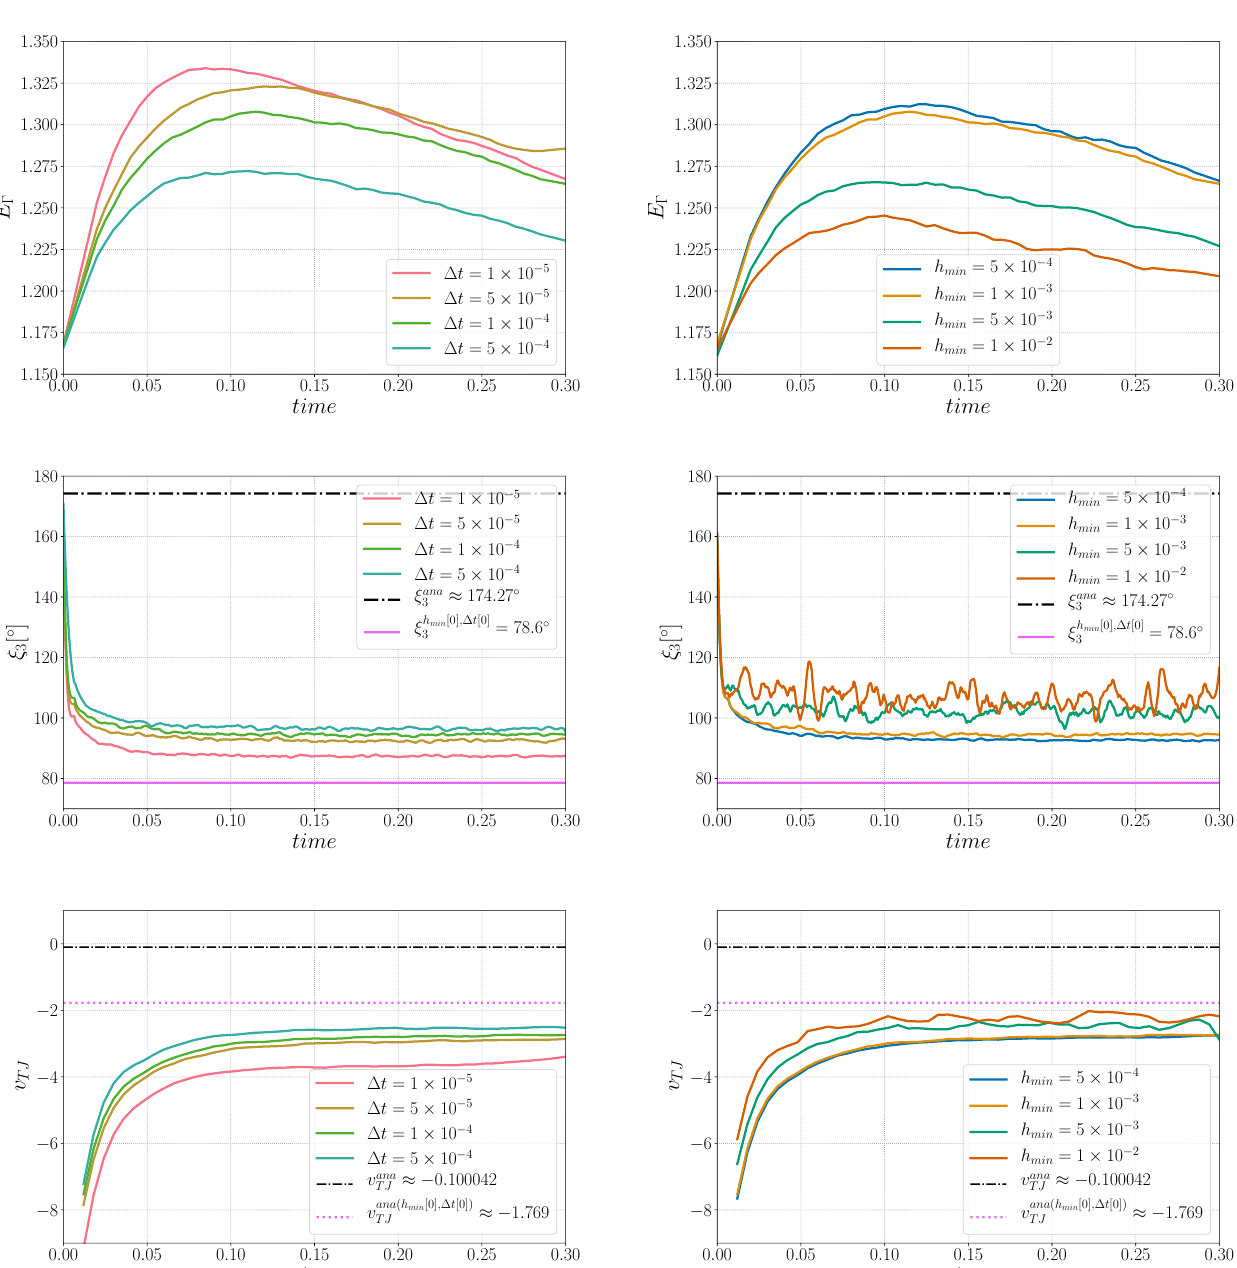
10 − 3 and in ( right ) h min size for ×